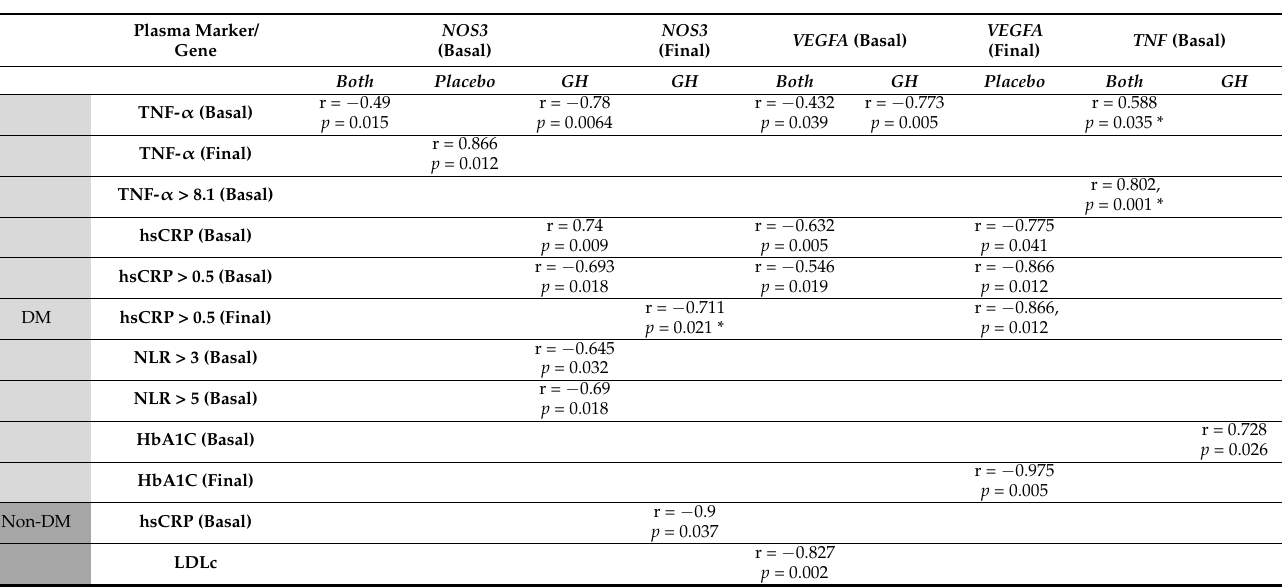
Table 4. Summary of correlations between plasma biomarkers and gene expression of NOS3 , VEGFA , and TNF . * Indicates that this condition was also found significantly associated in non-DM population of the GHAS trial.